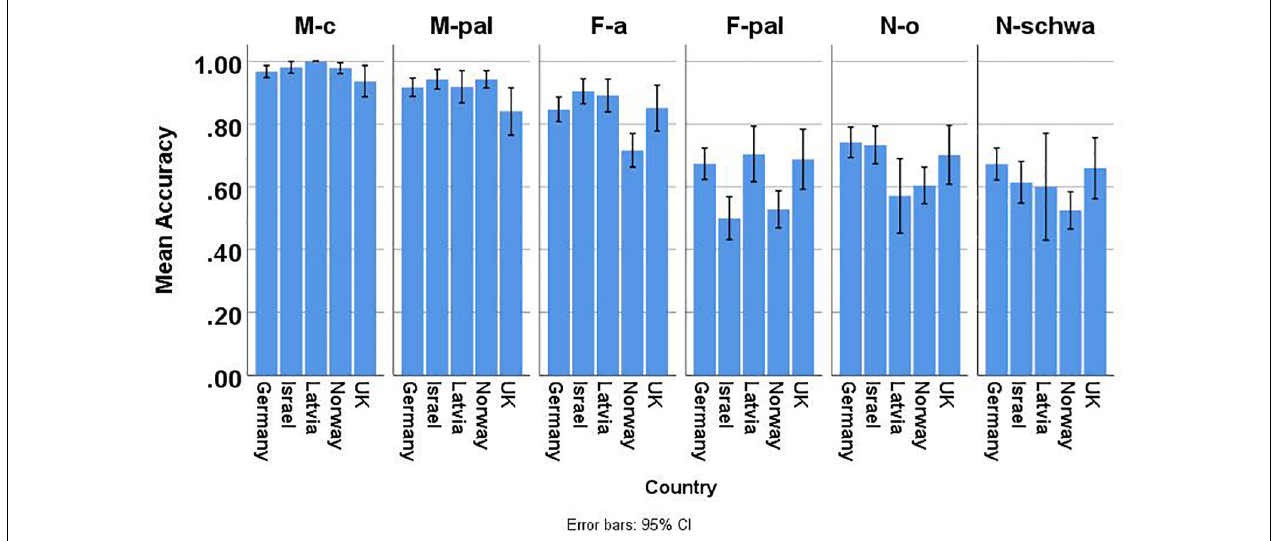
FIGURE 1 | Performance on real words per condition per